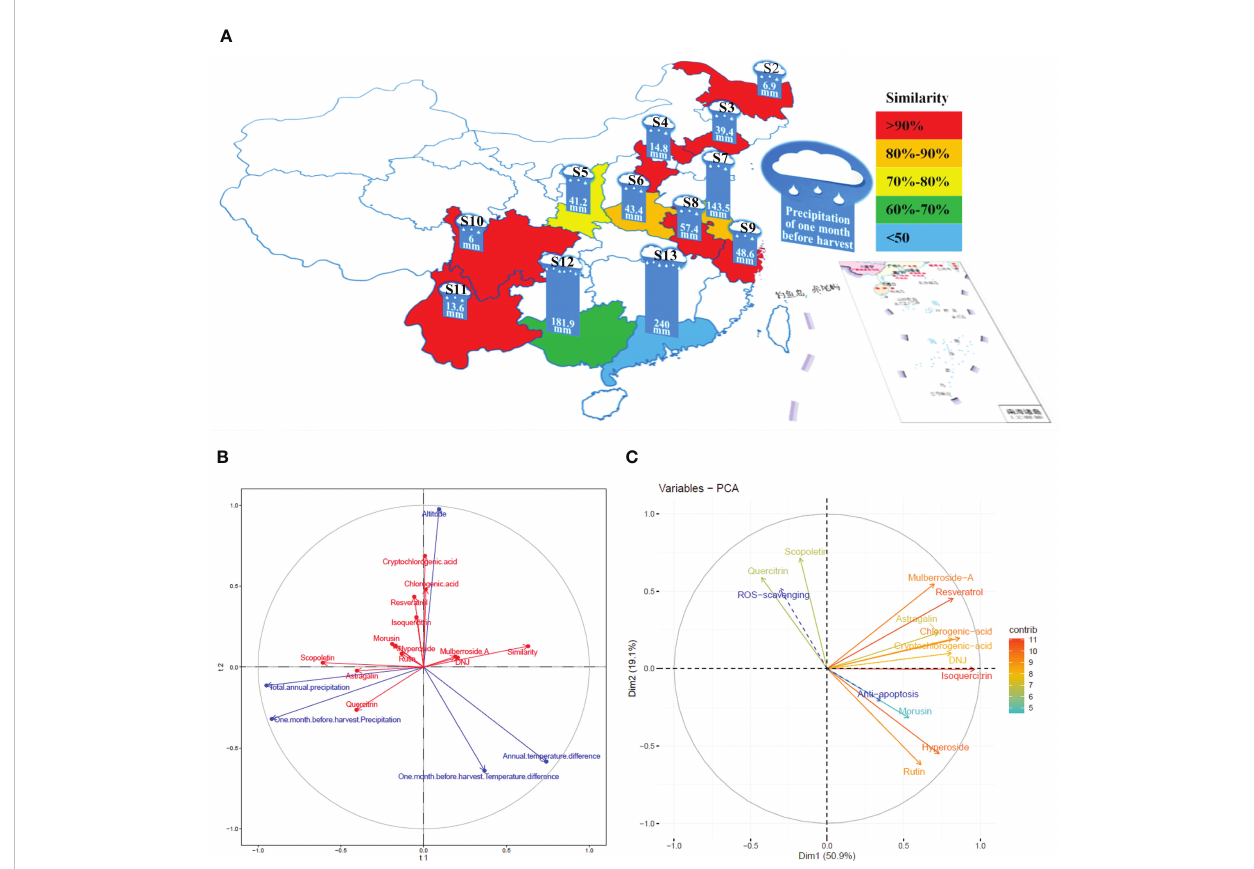
FIGURE 4 The correlation between the planting conditions of the planting areas, the constituents of the mulberry branch extract and the bioactivity variations were analyzed by partial least square regression (PLSR) and the “ FactoMineR ” software. S2, Heilongjiang; S3, Liaoning; S4, Hebei; S5, Shanxi; S6, Henan; S7, Jiangsu; S8, Anhui; S9, Zhejiang; S10, Sichuan; S11, Yunnan; S12, Guangxi; S13, Guangdong. (A) Precipitation in the month before harvest and the similarity of mulberry branches from different planting areas. Similarity: red > 0.9 (S2, S3, S4, S8, S9, S10, S11); 0.8 < orange < 0.9 (S6, S7); 0.7 < yellow < 0.8 (S5); 0.6 < green < 0.7 (S12); blue < 0.6 (S13). (B) The effects of planting conditions on the levels of constituents and the similarity of mulberry branches analyzed by PLSR: blue (planting conditions), red (constituents). The vector length of each composition represents the amount of change. The greater the change, the longer the vector length. The angle between the vector direction of the composition and the planting conditions represents the strength of the correlation. The more similar, the stronger the correlation is, and opposite direction represents negative correlation. (C) multiple factor analysis (MFA) based on reactive oxygen species (ROS) and apoptosis results in line with the constituents of mulberry branch extracts: the vector length and color of each composition in the mulberry branch extracts represent the contribution of the composition to the overall ef fi cacy. Color of vector (contribution degree, red direction represents greater contribution value, while blue direction represents the opposite), the angle between the vector direction of composition contribution (solid line arrow), and variation in speci fi c activity (dotted line arrow) represents the strength of the correlation: a smaller angle indicates stronger